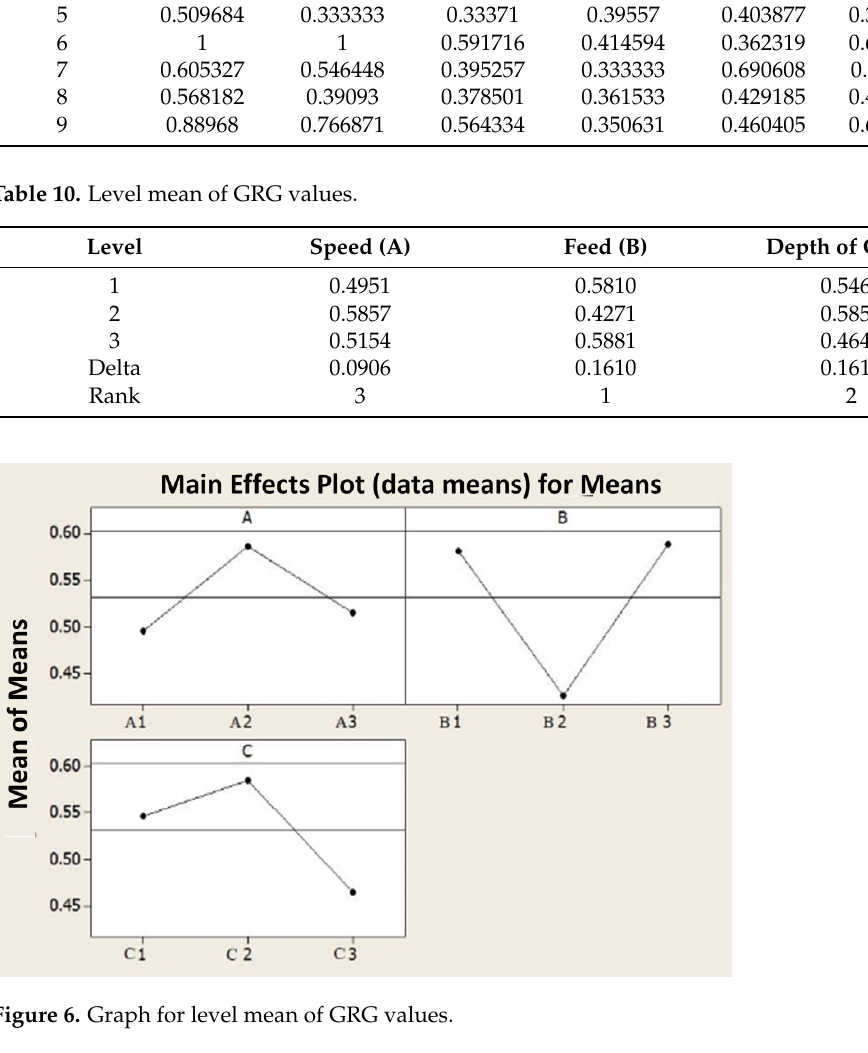
Figure 7. Graph for percentage of contribution of inputs for GRA technique. Table 11. Analysis of Variance for GRG values. Source